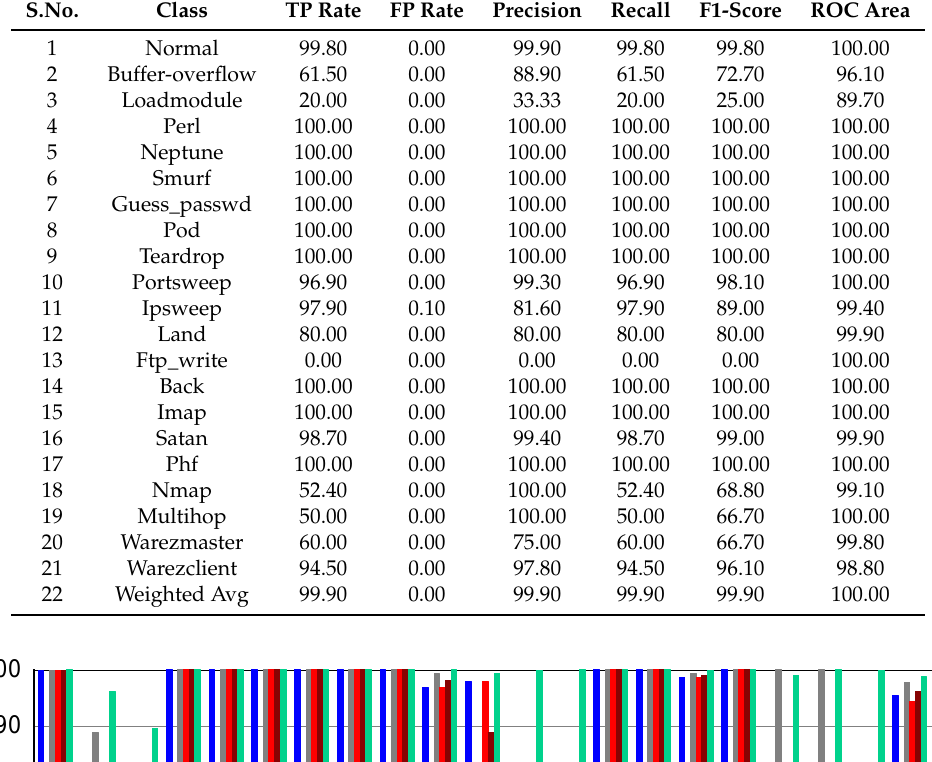
Table 22. Multiclass classification report for KDD99 using Adaboost Random Forest.